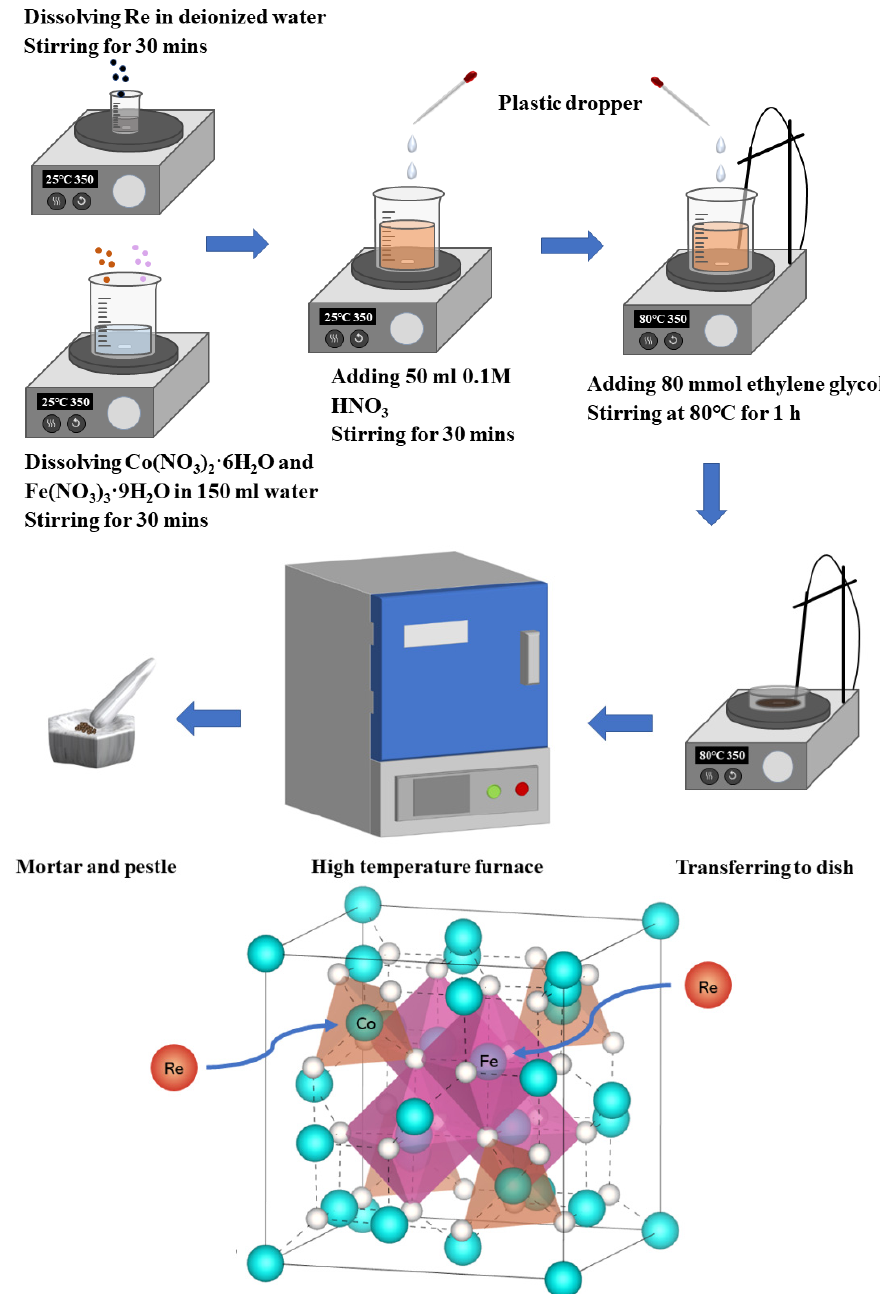
Figure 1. The crystal structure of the rhenium-doped cobalt ferrite illustrates the sol-gel synthesis procedure.